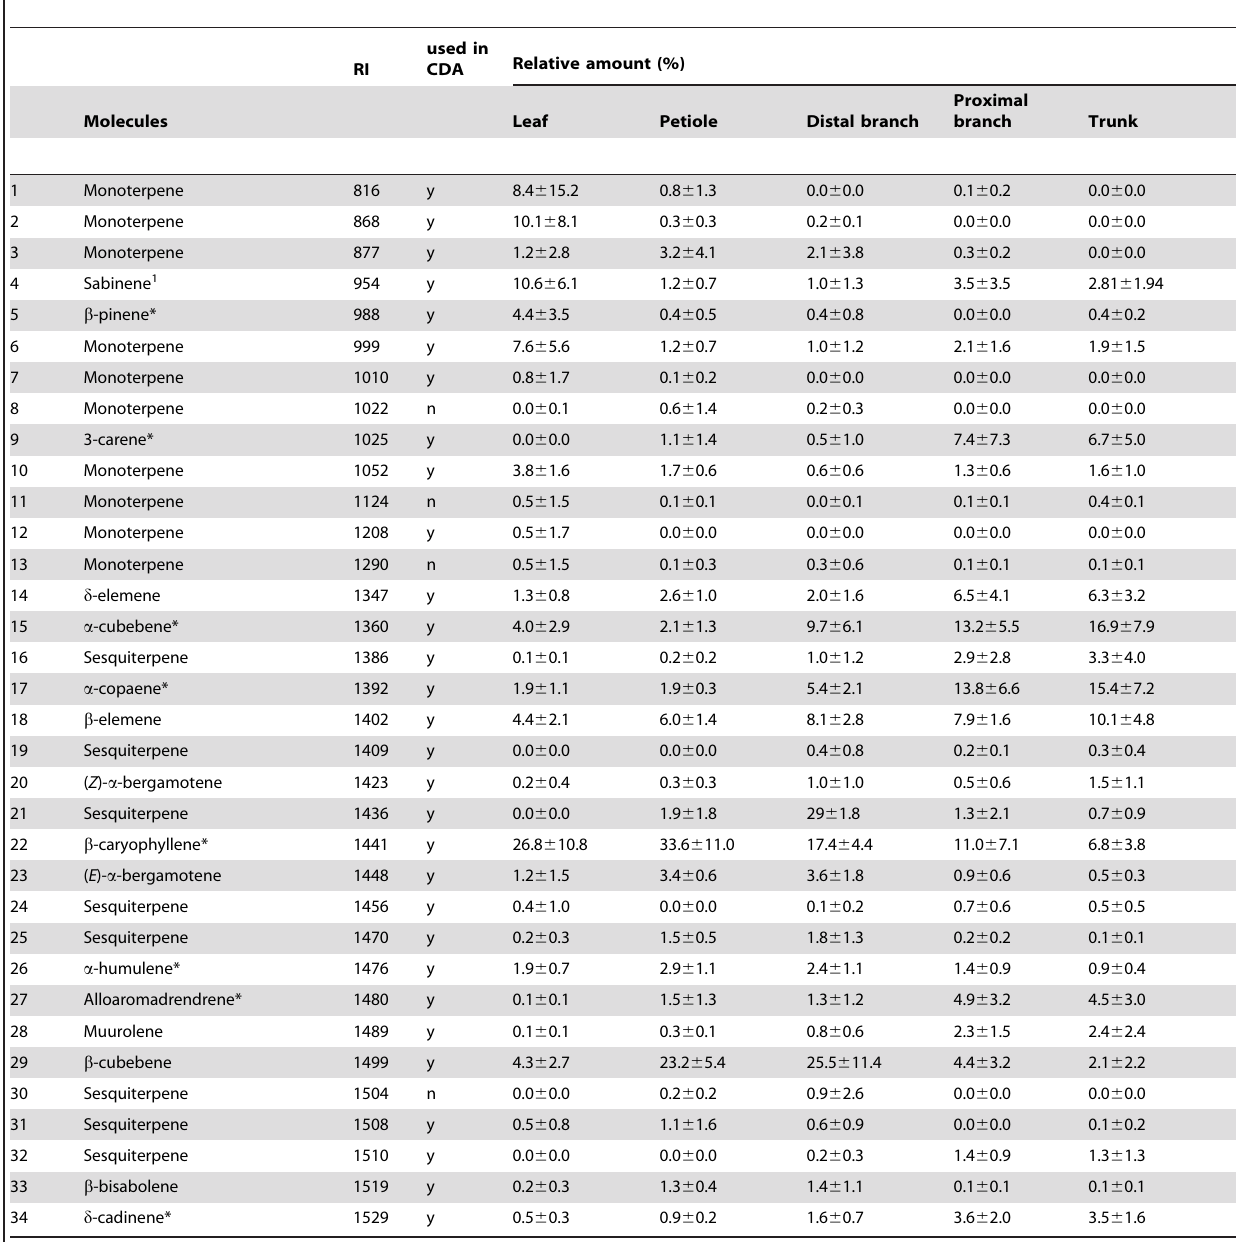
Table 2. Chemicals that comprised . 3% of volatile chemicals from plant material collected from four avocado trees (‘Melendez’ seedlings, n =3 per location per